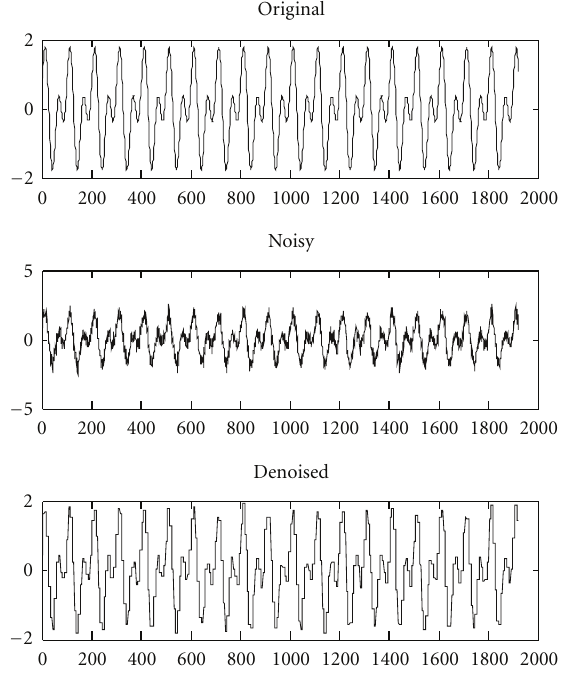
Figure 7: Wavelet denoising of a signal s ( t ).